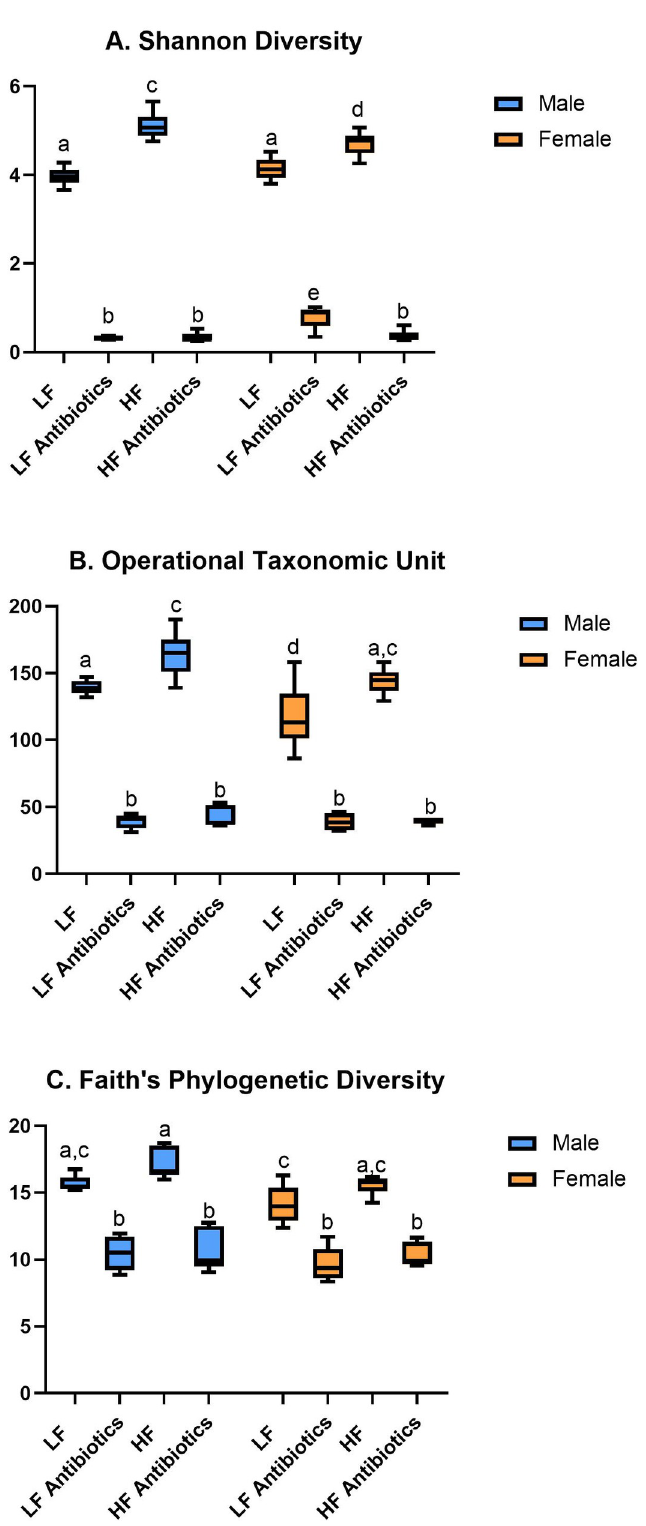
Fig 2. Fecal microbiome alpha diversity (n = 6/group). (A) There was a significant effect of treatment (p < 0.0001) and a significant interaction effect (sex x treatment; p = 0.0002) for Shannon Diversity. (B) There was a significant effect of treatment (p < 0.0001) and a significant effect of sex (p = 0.0021) on Operational Taxonomic Units. (C) There